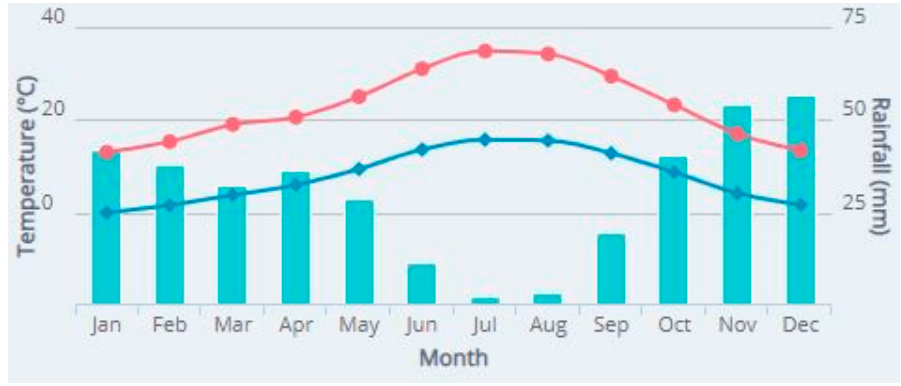
Figure 2. Climatological information based on monthly averages for the 30-year period 1971–2000 of the Territorial Context 1 [37]. Table 1. Description of Territorial Context 1.